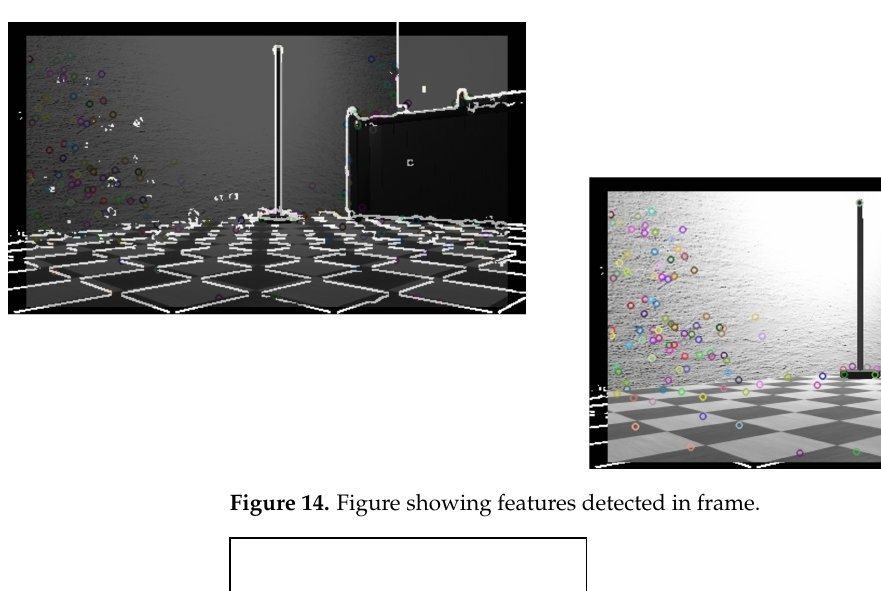
Figure 13. Figure showing key for agent alignment images.